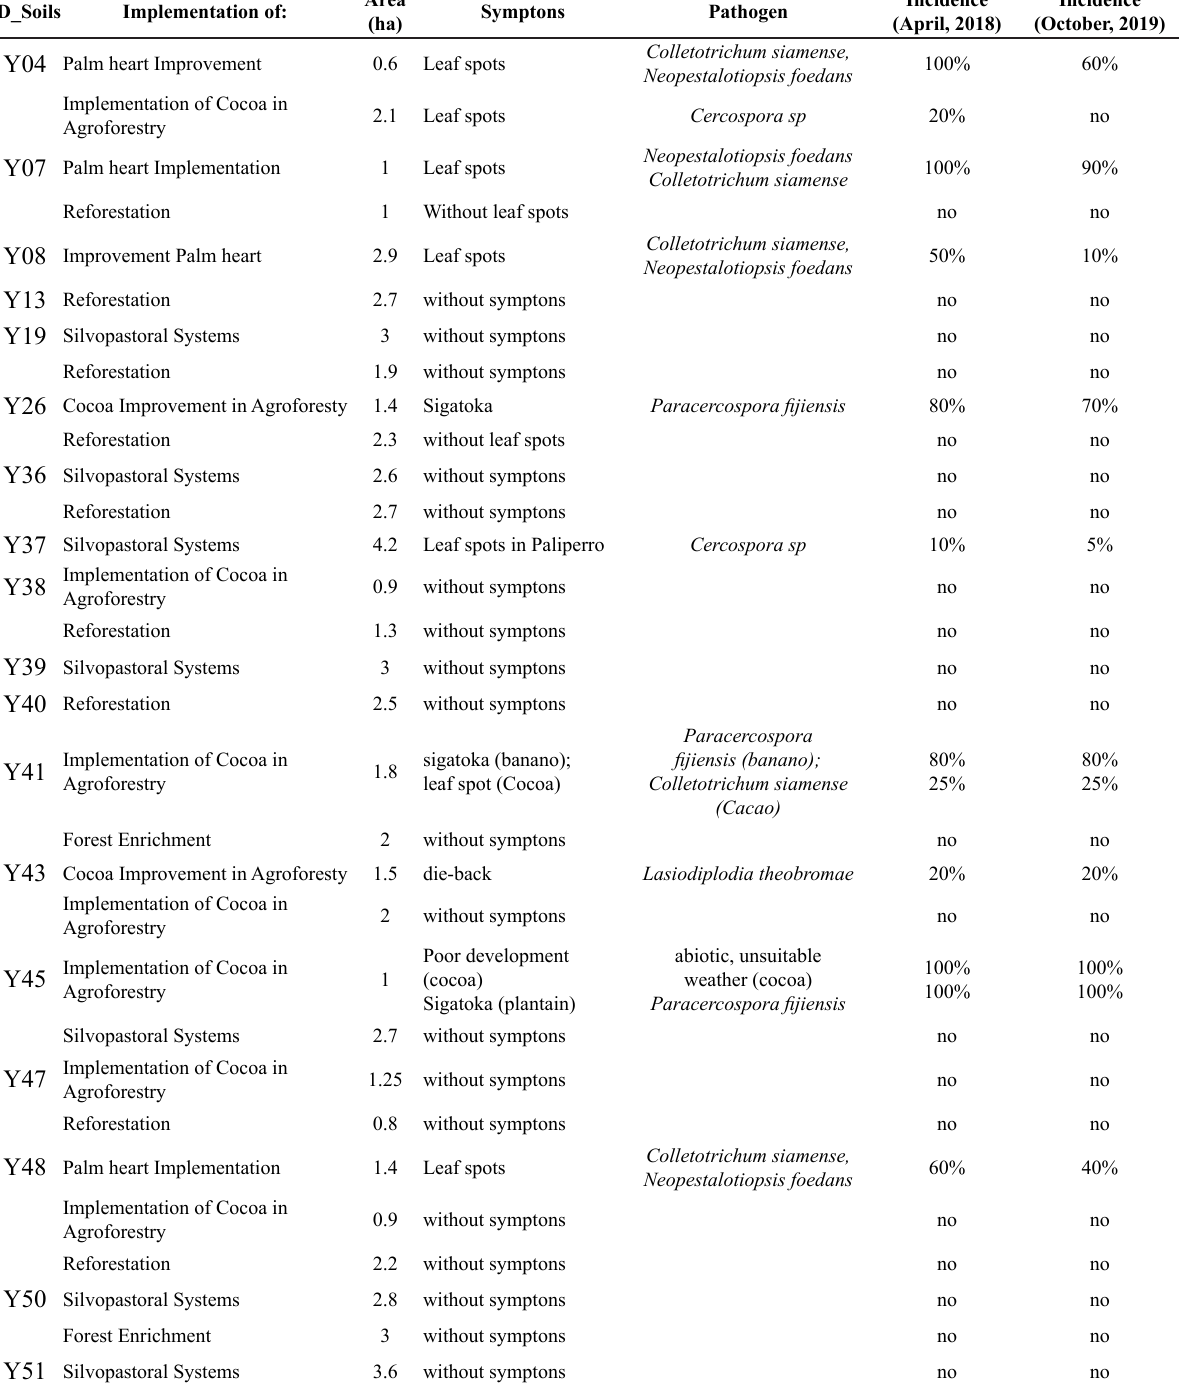
Table 1. Result of the phytopathological analyzes and molecular identification, as well as the incidence observed in the 2018 and 2019 sampling of the Farms (each one corresponds to a farmer) of Yurimaguas (Loreto) of the Sustainable Landscapes Project for the